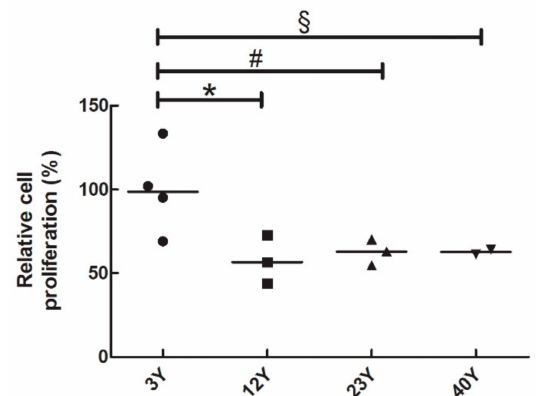
Figure 3. BrdU cell proliferation assay of equine SfMSCs cultured from donors at di ff erent ages. The values of each donor and the mean value (black line) inside each group are represented. All the data are expressed as percentages of relative amounts to a reference control group consisting of a pool of four di ff erent healthy equine subjects, each 3 years old. * represents a significant di ff erence between 3Y and 12Y groups; p < 0.05. # represents a significant di ff erence between 3Y and 22Y groups; p < 0.05. § represents a significant di ff erence between 3Y and 40Y groups; p < 0.05.